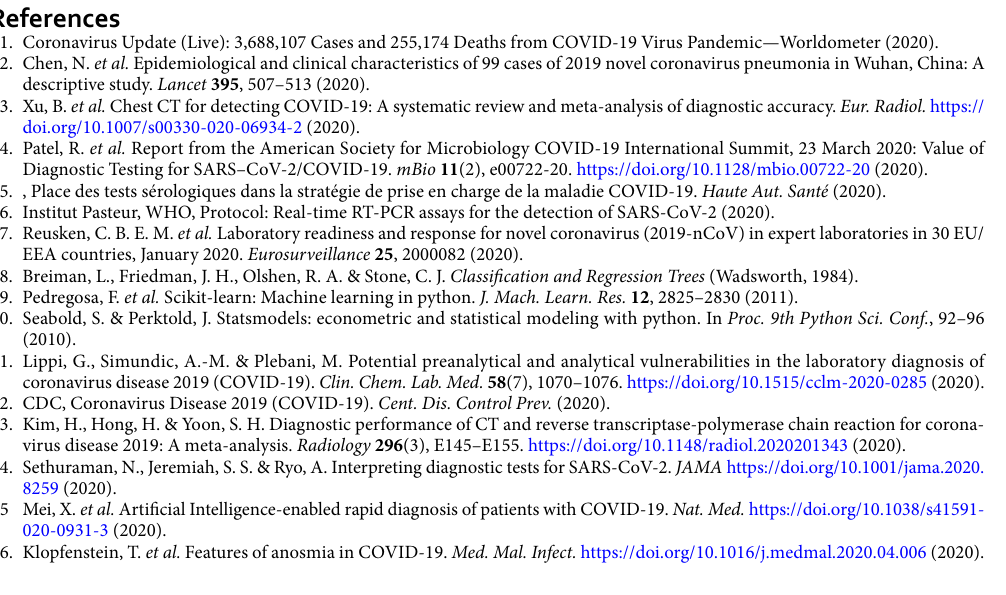
Figure 4. Added value of RT-PCR testing in patients with clinically suspected moderate Covid-19 infection based on their symptoms. ( a ) Proposal of a diagnostic strategy in medical practice, for patients with clinical suspicion of moderate Covid-19 infection by a physician. Anosmia or ageusia are predictive of RT-PCR+ and these patients could be diagnosed based on clinical symptoms only. In case of fever and cough, RT-PCR testing has a good diagnostic value. Then, breathlessness associated with chest pain or oppression is predictive of RT-PCR−, although these symptoms may be signs of Covid-19 pulmonary infection. Therefore, RT-PCR is little valuable in this group and an alternative investigation, such as chest imaging, is indicated. For the remaining patients, RT-PCR is of little added value, but this group is heterogeneous and RT-PCR or alternative investigations should be considered depending on the clinical presentation. ( b ) Description of the different clinical groups defined by the decision tree. The non-weighted numbers, proportions and odds-ratios of being RT-PCR+ in each group are provided. RT-PCR testing has a different added value for each group: it is less useful for groups with RT-PCR+ odds ratios far away from 1. ( c ) Same description as ( b ) with propensity-score weighing. Findings are